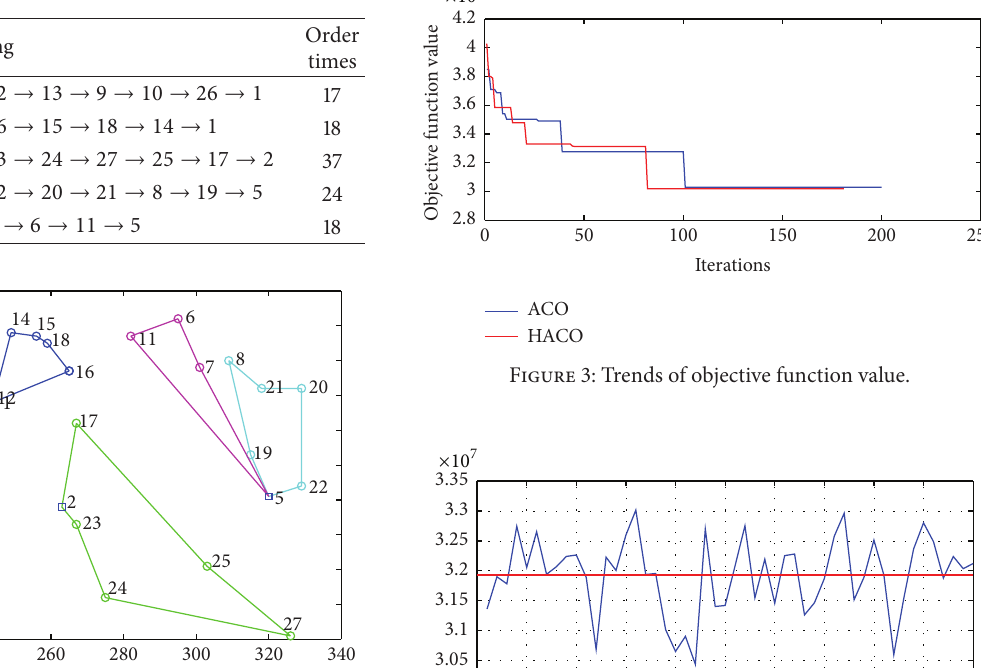
Table 7: The solution of Gaskell 67-22 × 5.